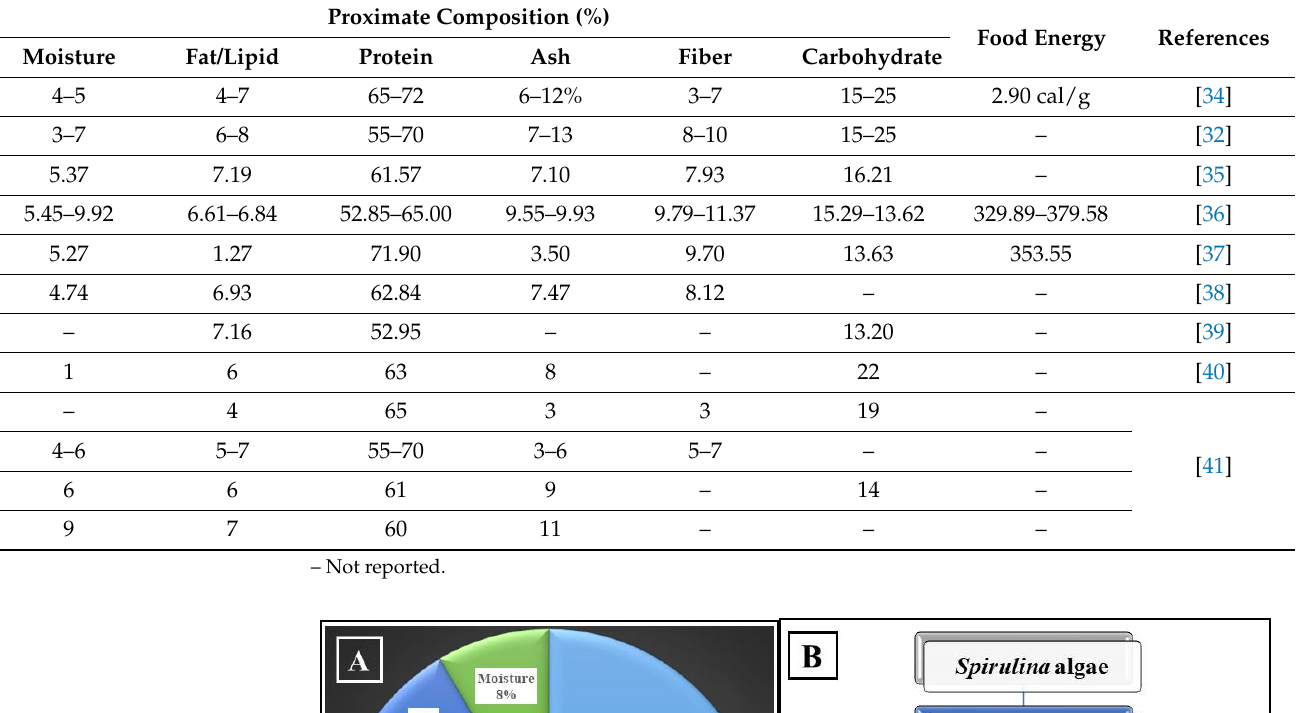
Table 1. The value of proximate composition of spirulina from different reported research. Proximate Composition (%) Food Energy